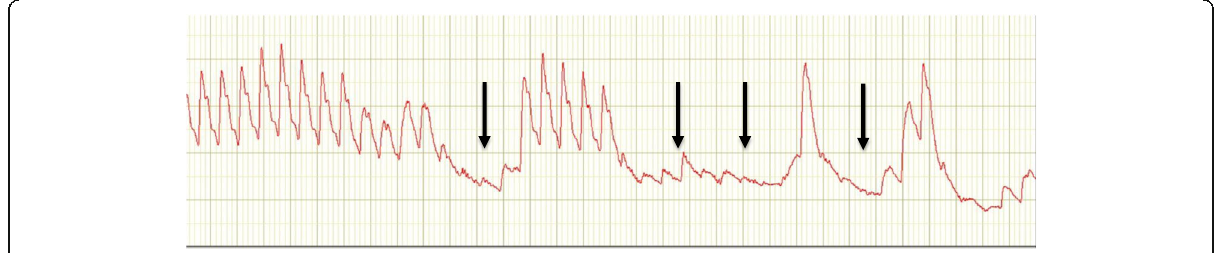
Fig. 1 Left radial artery pressure waveform. Pulse pressure was highly reduced and disappeared intermittently (black